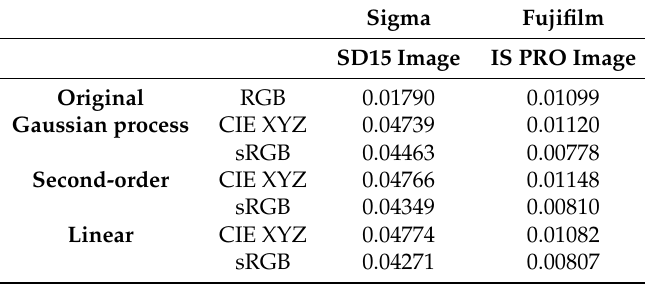
Table 7. Summary of the variation coefficients